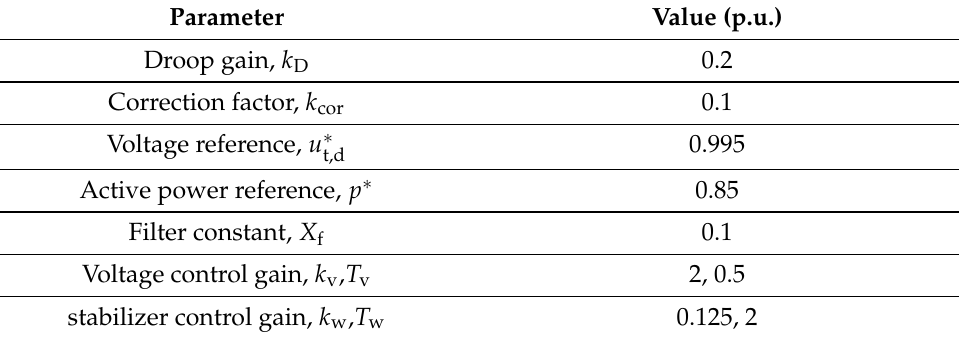
Table A2. Control block parameters shown in Figures 9, 12, 13 and